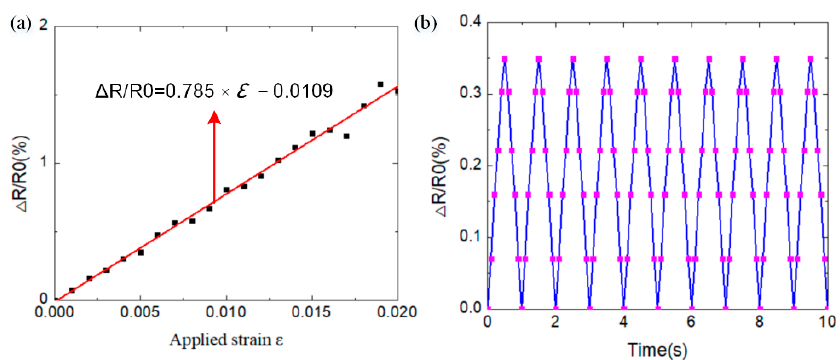
Figure 8. Strain sensor data from the strain sensor agent: ( a ) variable resistance value with the external strain; ( b ) repeated load and unload process for the strain sensor.